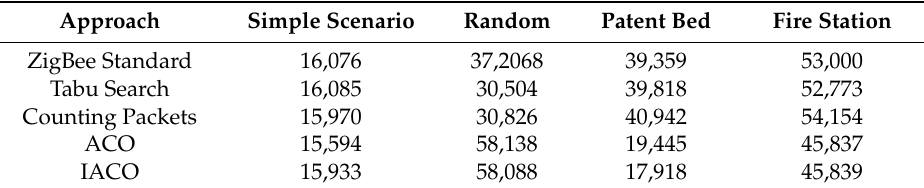
Table 22. Throughout Comparison.